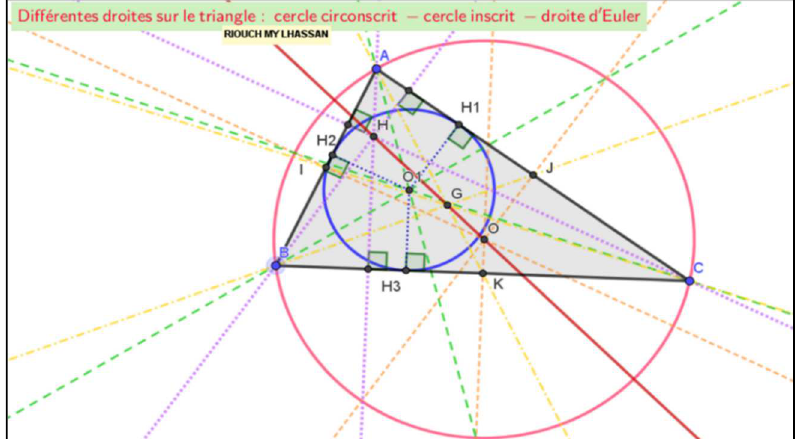
Fig. 5. Cercle circonscrit- inscrit du triangle – centre de gravité- orthocentre – Droite